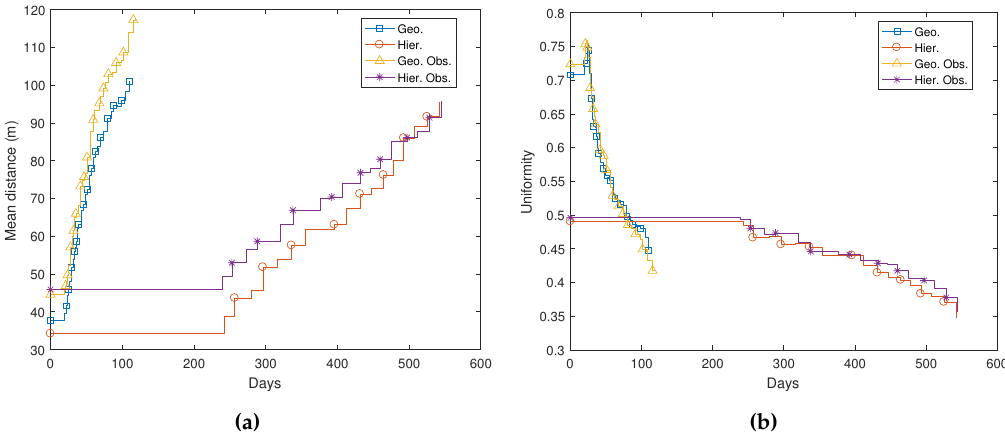
Figure 15. Node distribution evolution in time: ( a ) mean distance per (living) node; ( b ) network